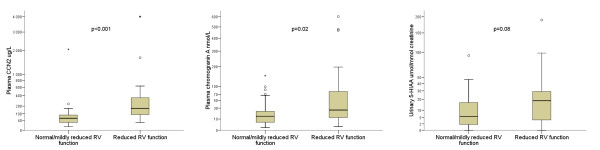
Relationship between plasma connective tissue growth factor, chromogranin A and urinary 5-hydroxyindoleacetic acid and right ventricular function. Box plots displaying the relationship between plasma connective tissue growth factor (CCN2), chromogranin A (CgA) and urinary 5-hydroxyindoleacetic acid (U-5HIAA) levels and right ventricular (RV) function. Median, interquartile ranges, and maximum and minimum values are shown. Due to the presence of extreme outliers, values are plotted on the y-axis using a logarithmic (log e) scale. P-values are determined using Mann-Whitney U test.